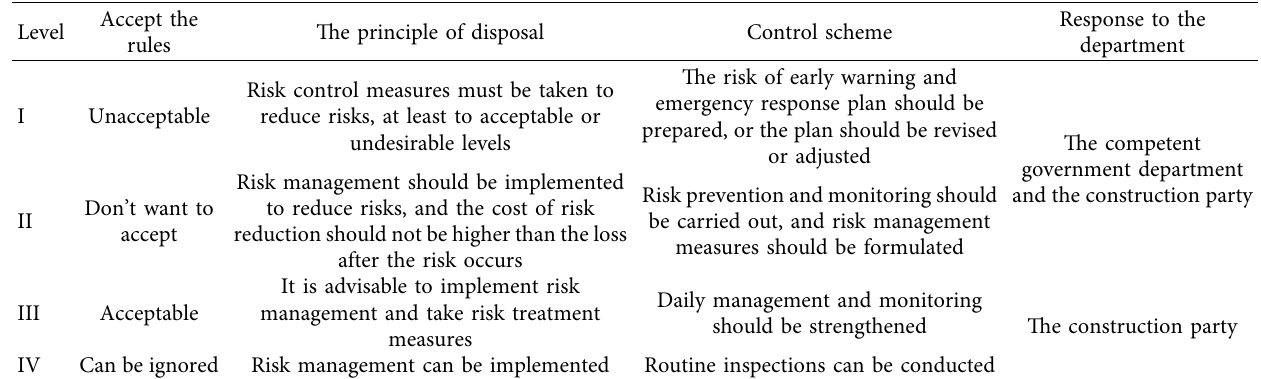
Table 11: Risk acceptance